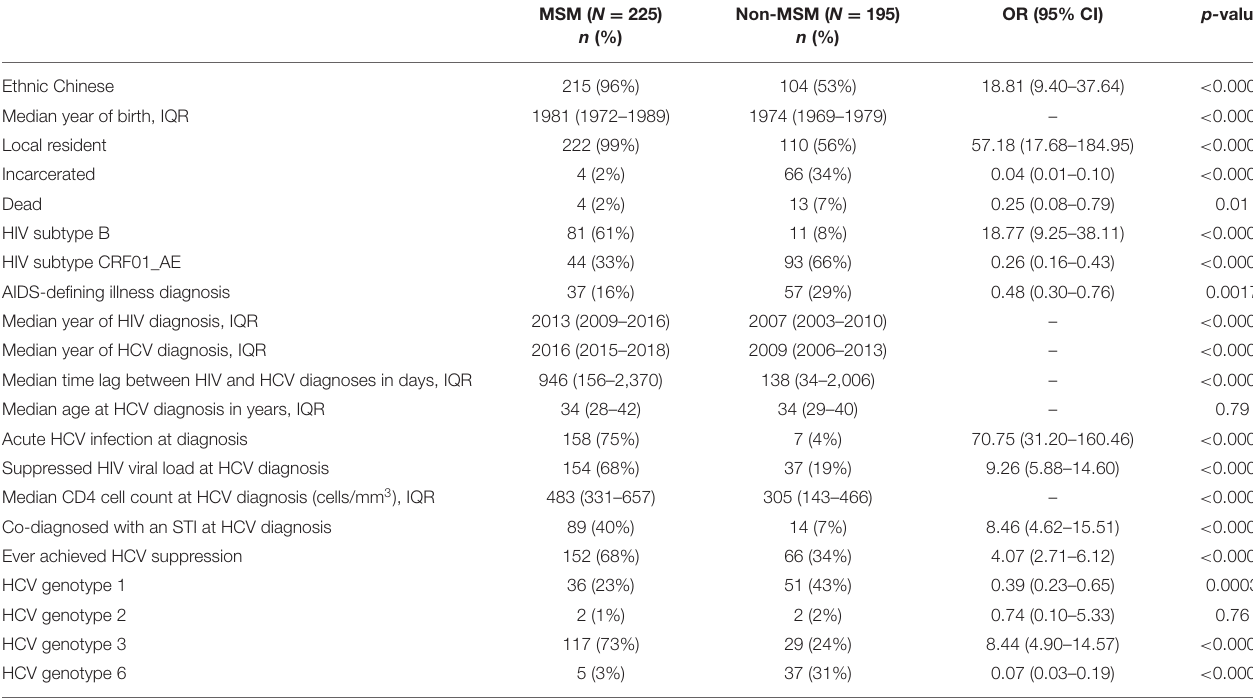
TABLE 2 | Comparison between MSM and non-MSM HIV/HCV co-infected patients ( N =